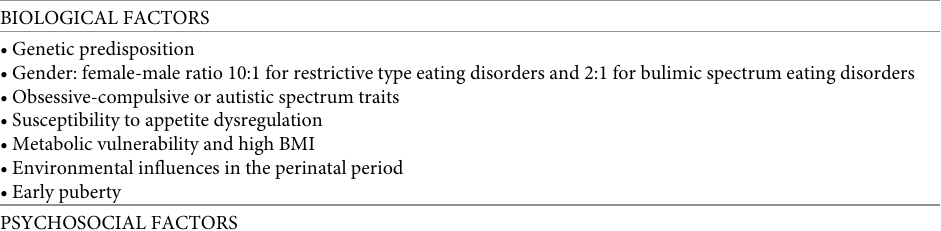
Table 2. The complex aetiology of eating